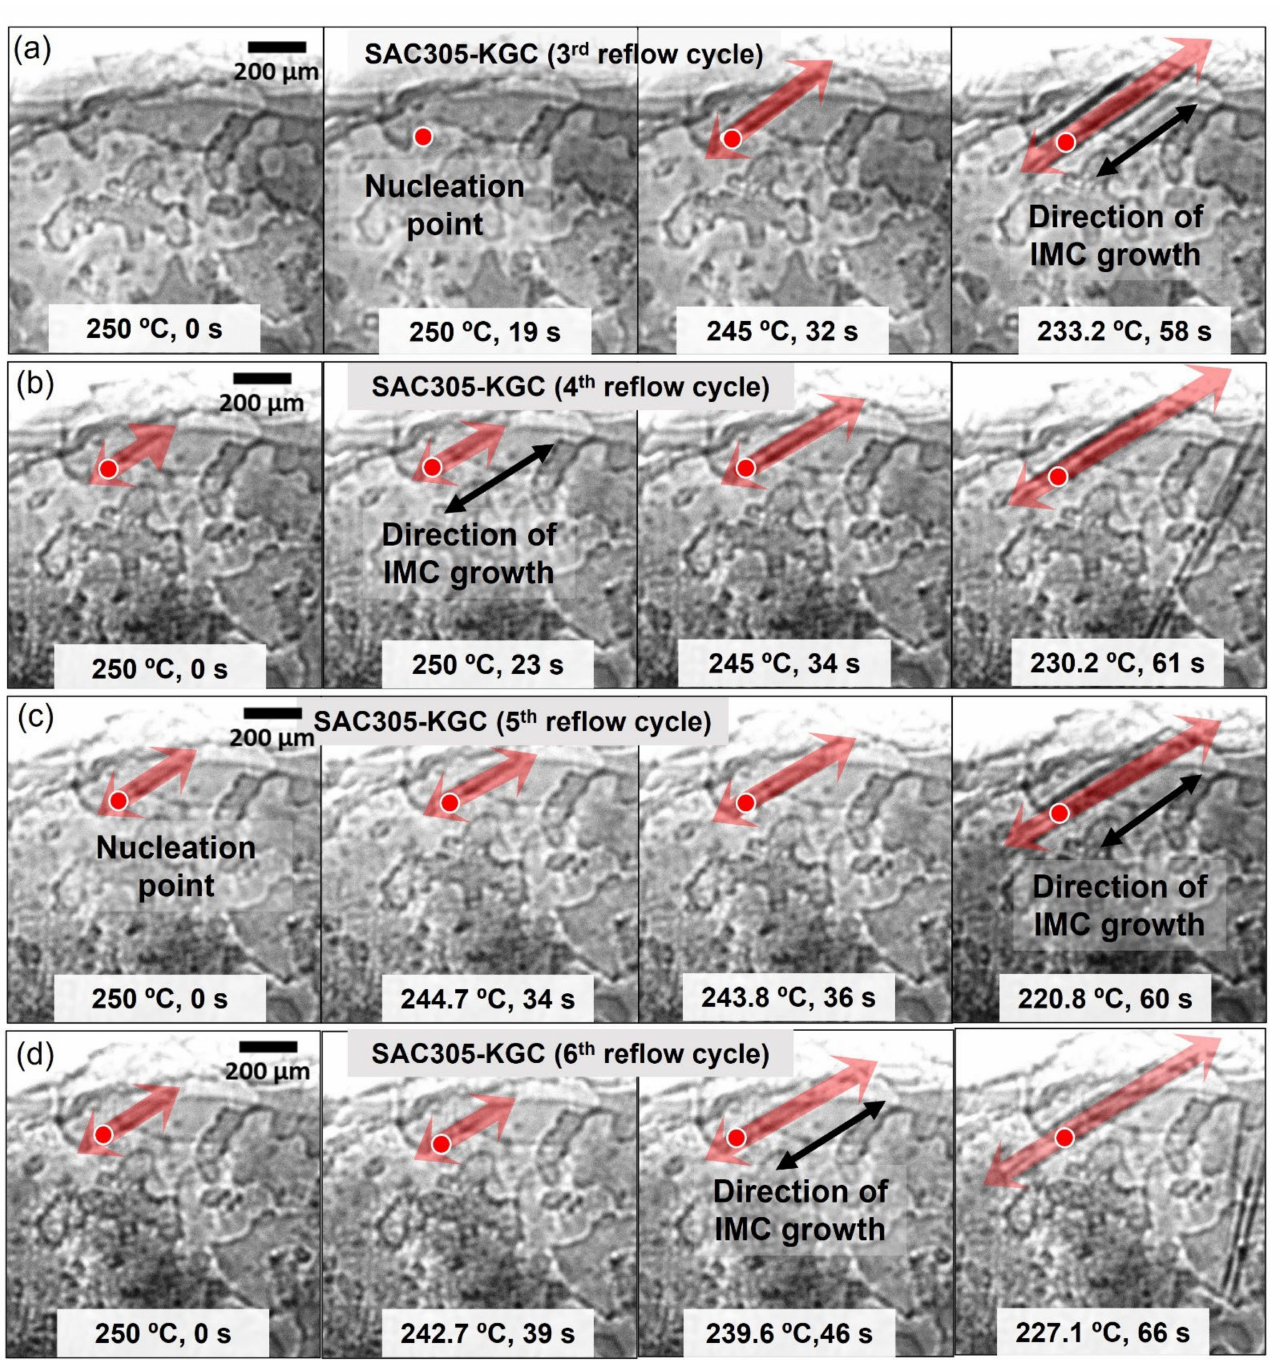
Figure 9. Sequences of the image showing the growth of IMC in SAC305-KGC solder joints during ( a ) 3rd reflow cycle, ( b ) 4th reflow cycle, ( c ) 5th reflow cycle, and ( d ) 6th reflow cycle (t = 0 s when the sample begins to